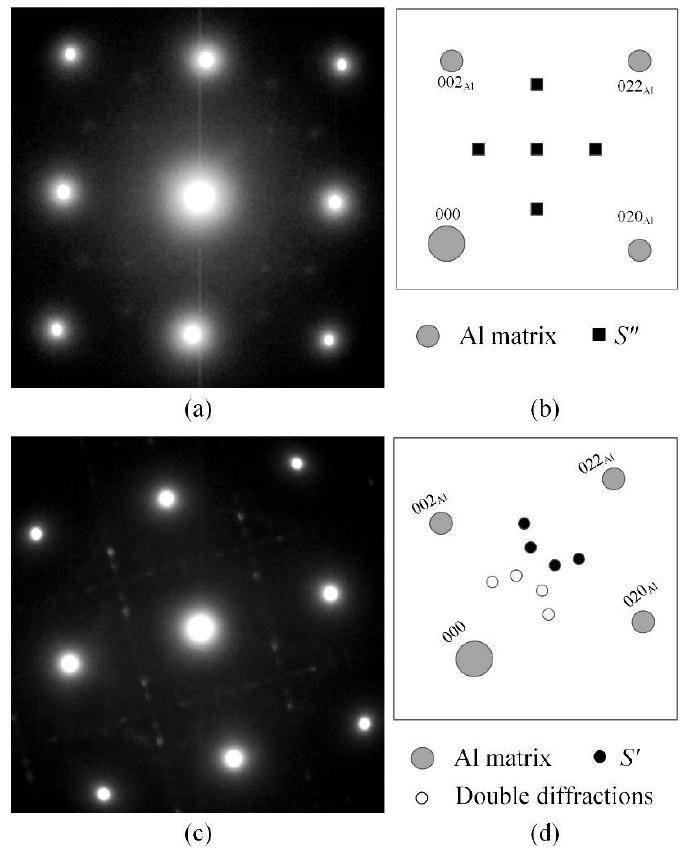
Figure 5. SAED patterns along a <100> Al zone axis and corresponding schematic diagrams for AA2524: ( a , b ) CAF-4h; ( c , d ) CAF-24h.